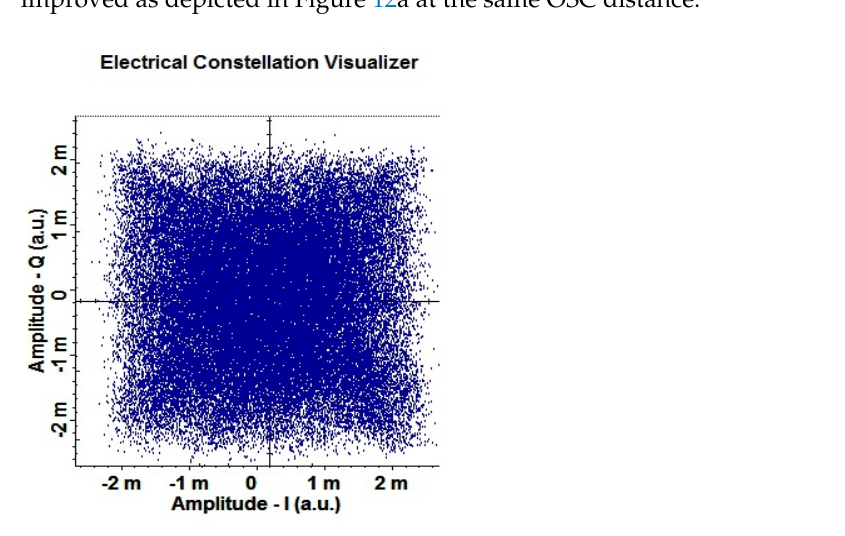
Figure 14. Representation of SNR versus OSC link lengths in the case of three OAM beams. 4.1. A Detailed Comparison of Proposed OAM ‐ OSC System with Reported OSC Systems In this section, the performance of the proposed OAM ‐ OSC system is compared with the different reported OSC systems in terms of data rate, channels, capacity, OSC link length, modulation used, multiplexing employed, and performance, as shown in Table 2. It is observed that the highest capacity is accomplished in the proposed work as compared to [41,42,44,61–63]. Moreover, the use of DQPSK [41], 4 ‐ QAM/PSK ‐ OFDM [43], PDM ‐ QPSK [44], SP ‐ QAM [59], PDM ‐ 4 ‐ QAM [37], PDM ‐ 16 ‐ QAM [58], PDM ‐ 64 ‐ QAM [59], and PDM ‐ 128 ‐ QAM [62] have been reported in these researches. However, the proposed system has employed high spectral efficiency (eight bits per symbol) based PDM ‐ 256 ‐ QAM in OSC ‐ OAM system. As far as multiplexing is concerned, MDM was used by [41,43,44], but due to the consecutive or lesser differences in LG/HG mode profiles, more deterioration and limited reach were obtained. On the other side, the proposed OAM ‐ enabled OSC system with PDM ‐ 256 ‐ QAM offered the highest capacity, ultra ‐ long reach, and high cost ‐ effec ‐ tiveness using single wavelength thrice for data modulation with OAM beams.